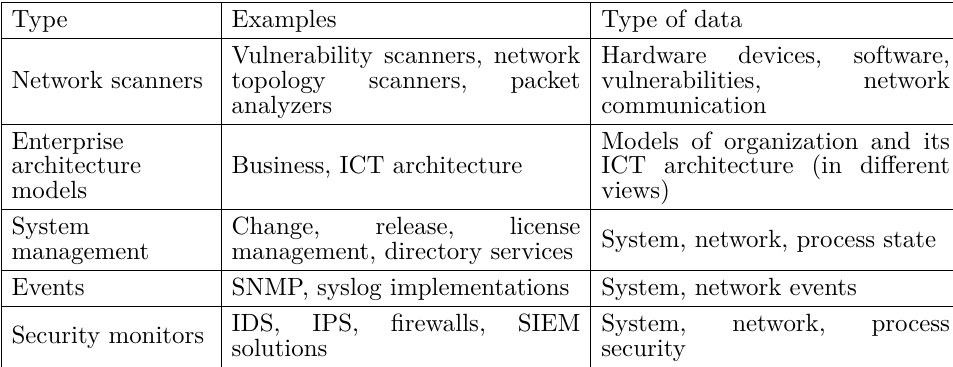
Table 1. Examples of possible data sources for system